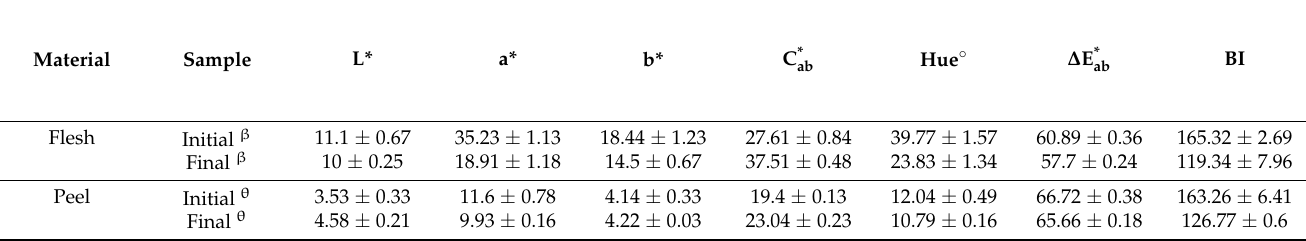
Table 2. Values of L*, a*, b*, C ∗ after the concentration by RO membrane (X20).